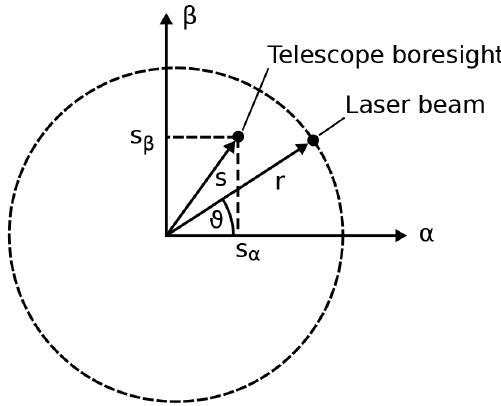
Figure 4. Angular modulation of the scan mirror.